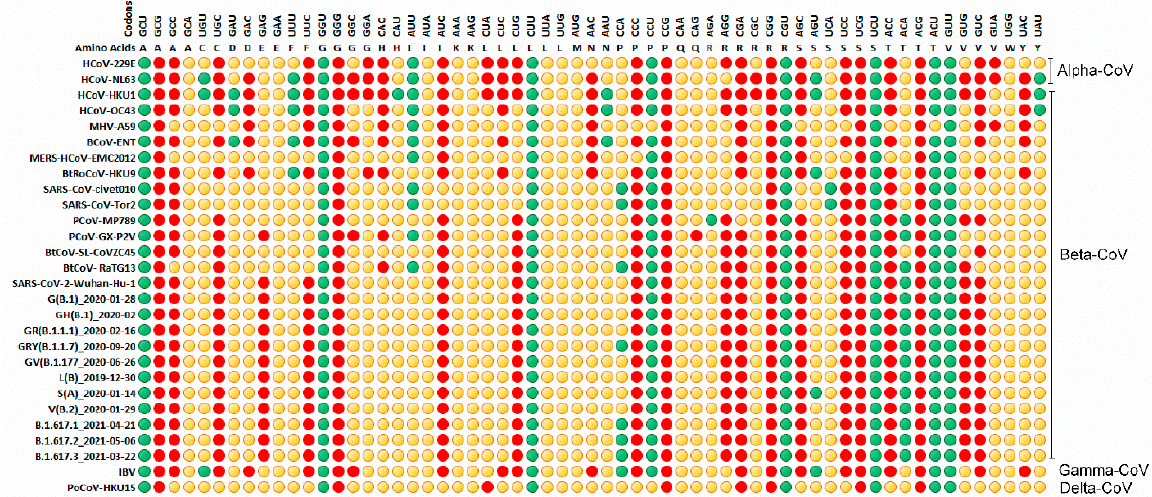
Figure 7. The relative synonymous codon usage in the full genomic coding sequences across the four genera of CoVs infecting diverse hosts. The synonymous codons were divided into three groups based on their relative synonymous codon usage (RSCU) values: RSCU > 1.6, green colored; RSCU < 1.6 to >0.6, yellow colored; and RSCU < 0.6, red colored.